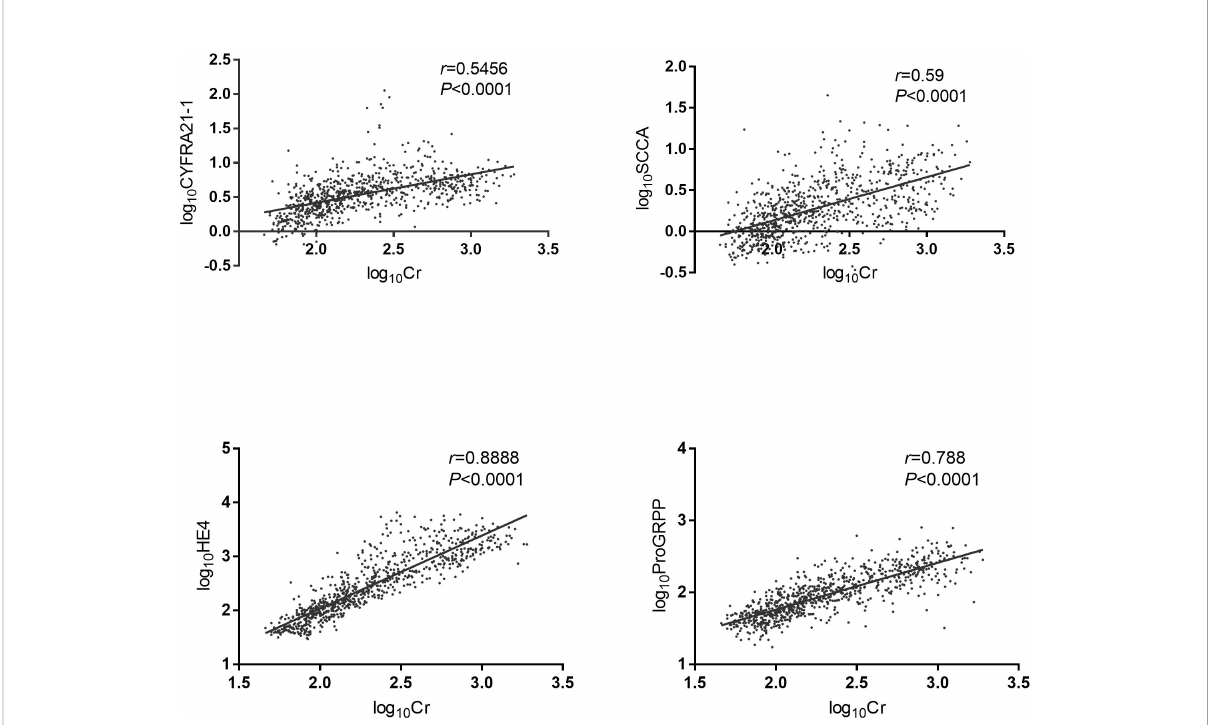
FIGURE 1 Correlation analysis of lung cancer-related tumor markers and serum creatinine. The data were analyzed by Person correlation after common logarithmic transformation. HE4: human epididymis protein 4; CYFRA21-1: cytokeratin fragment 19; SCCA: squamous cell carcinoma antigen; ProGRP: pro-gastrin-releasing peptide; Cr: creatinine. Log 10 HE4: the logarithm of HE4 concentration to the base 10. Log 10 CYFRA21-1: the logarithm of CYFRA21-1 concentration to the base 10. Log 10 SCCA: the logarithm of SCCA concentration to the base 10. Log 10 ProGRP: the logarithm of ProGRP concentration to the base 10. Log 10 Cr: the logarithm of creatinine concentration to the base